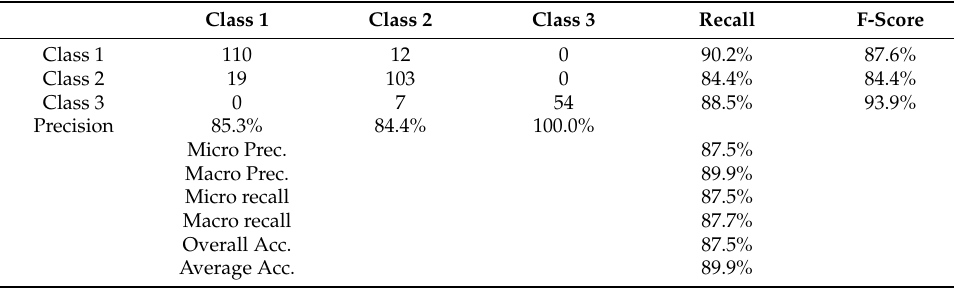
Table 4. The classification byVGG16 with 21 epoch.